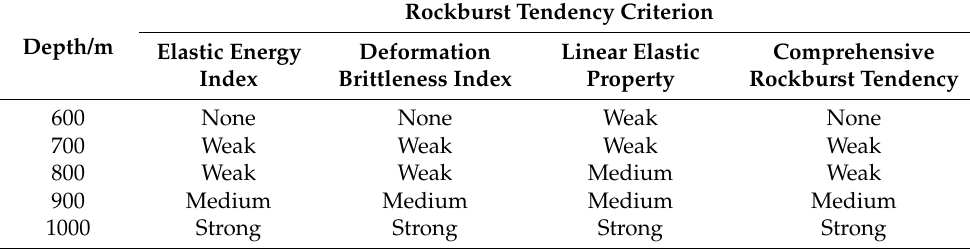
Table 5. Rockburst tendencies based on multiple criteria [25,26].